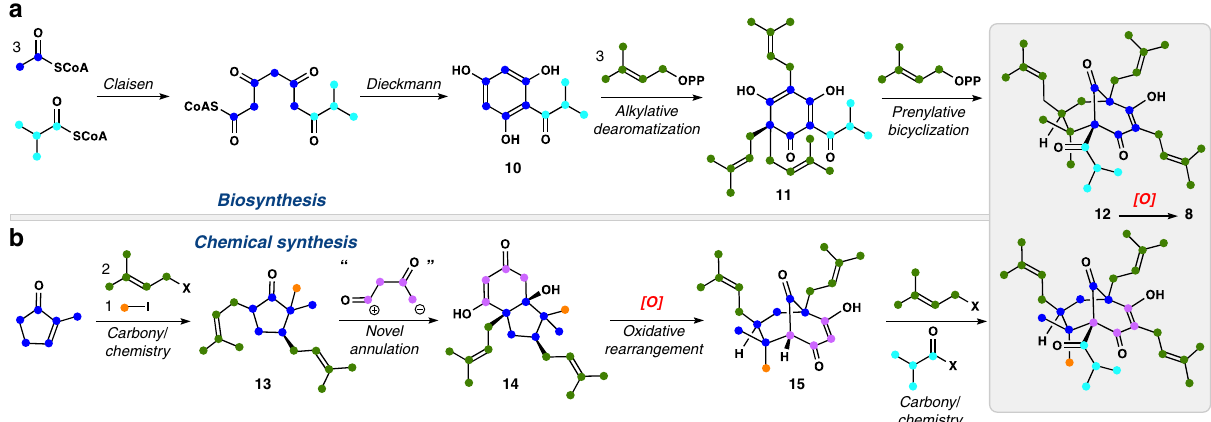
Fig. 2 Approaches to the synthesis of bicyclo[3.3.1]nonane-containing meroterpenes. a Nature ’ s presumed synthetic route employing polyketide assembly of an aromatic precursor followed by various C – C bond-forming prenylation events. b An abiotic synthetic strategy allows for similarly rapid and modular assembly of complex meroterpene architectures.